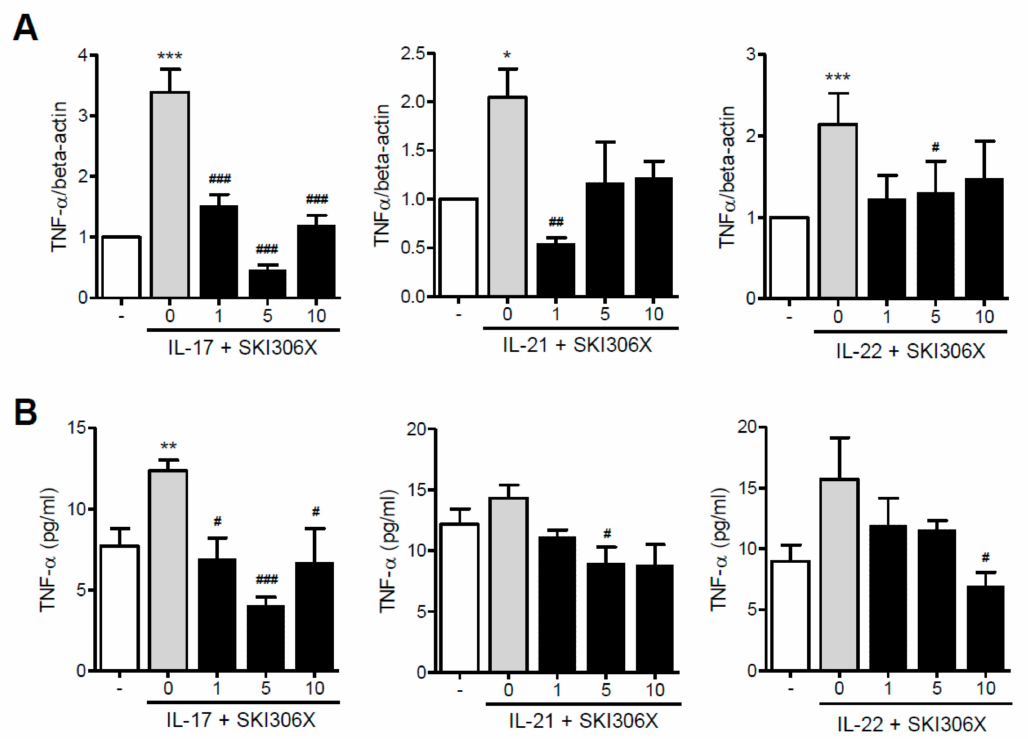
Figure 1. The inhibitory e ff ect of SKI306X, a mixed extract of three herbs, in T helper (Th)17 cytokine-induced tumor necrosis factor (TNF)- α expression and production by synovial fibroblasts in rheumatoid arthritis (RA). ( A ) RA synovial fibroblasts were cultured in media supplemented with interleukin (IL)-17, IL-21, and IL-22 in the presence of various doses of SKI306X, and TNF- α was examined using real-time PCR, normalized to that of beta-actin and reported in relative expression units. ( B ) RA synovial fibroblasts were cultured with IL-17, IL-21, and IL-22 in the presence of various concentrations of SKI306X, and TNF- α production in culture media was determined using ELISA. The data represent the mean ± standard deviation (SD) values from six independent experiments. * p < 0.05, ** p < 0.01 and *** p < 0.001 compared with the nil condition (white bars). # p < 0.05, ## p < 0.01 and ### p < 0.001 compared with the Th17 cytokine stimulating condition (gray